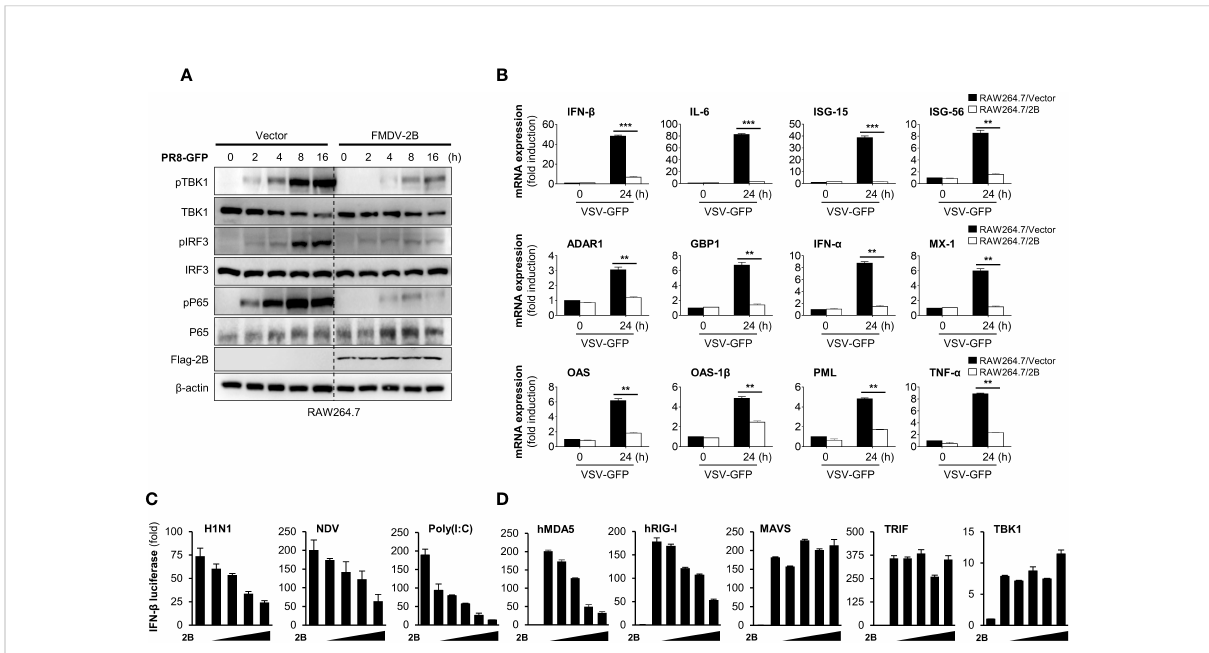
FIGURE 2 FMDV 2B inhibit the transcription of antiviral genes and type-I IFN signaling. Control vector and FMDV 2B stably expressing RAW264.7 cells were infected with PR8-GFP. Cells were harvested at indicated time points after the infection of PR8-GFP. Total and phosphorylated TBK1, IRF3, and p65 were measured by immunoblotting. b -actin was used as the loading control (A) . Control vector and FMDV 2B stably expressing RAW264.7 cells were infected with VSV-GFP. At 0 and 24 hpi, cells were harvested, and quantitative real-time PCR was performed to analyze the levels of antiviral genes (B) . HEK293T cells were transfected with interferon- b promoter encoding fi re fl y luciferase plasmid, TK-Renilla plasmid, increasing dose of Flag-FMDV 2B plasmid and stimulated with H1N1, NDV infection, Poly(I:C) treatment (C) or transfected with MDA5, RIG-I, MAVS, TRIF, and TBK1 encoding plasmids (D) for 24 hours. Results are expressed relative to those of Renilla luciferase alone (internal control). Results representative of at least two independent experiments, each with similar results, and the values are expressed as mean ± SD of three biological replicates. Student ’ s t-test; **p < 0.01; ***p <